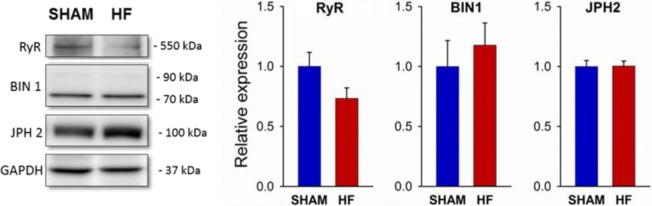
HF in post-infarction rats is not associated with altered expression of RyR, BIN1, or Junctophilin-2.Western blotting was performed on homogenates of left ventricles from post-MI HF rats and Sham-operated controls. Representative immunoblots are shown at left, with mean values at right, normalized to Sham. (JPH2 = junctophilin 2; nhearts = 5, 5 in Sham, HF; P = NS).